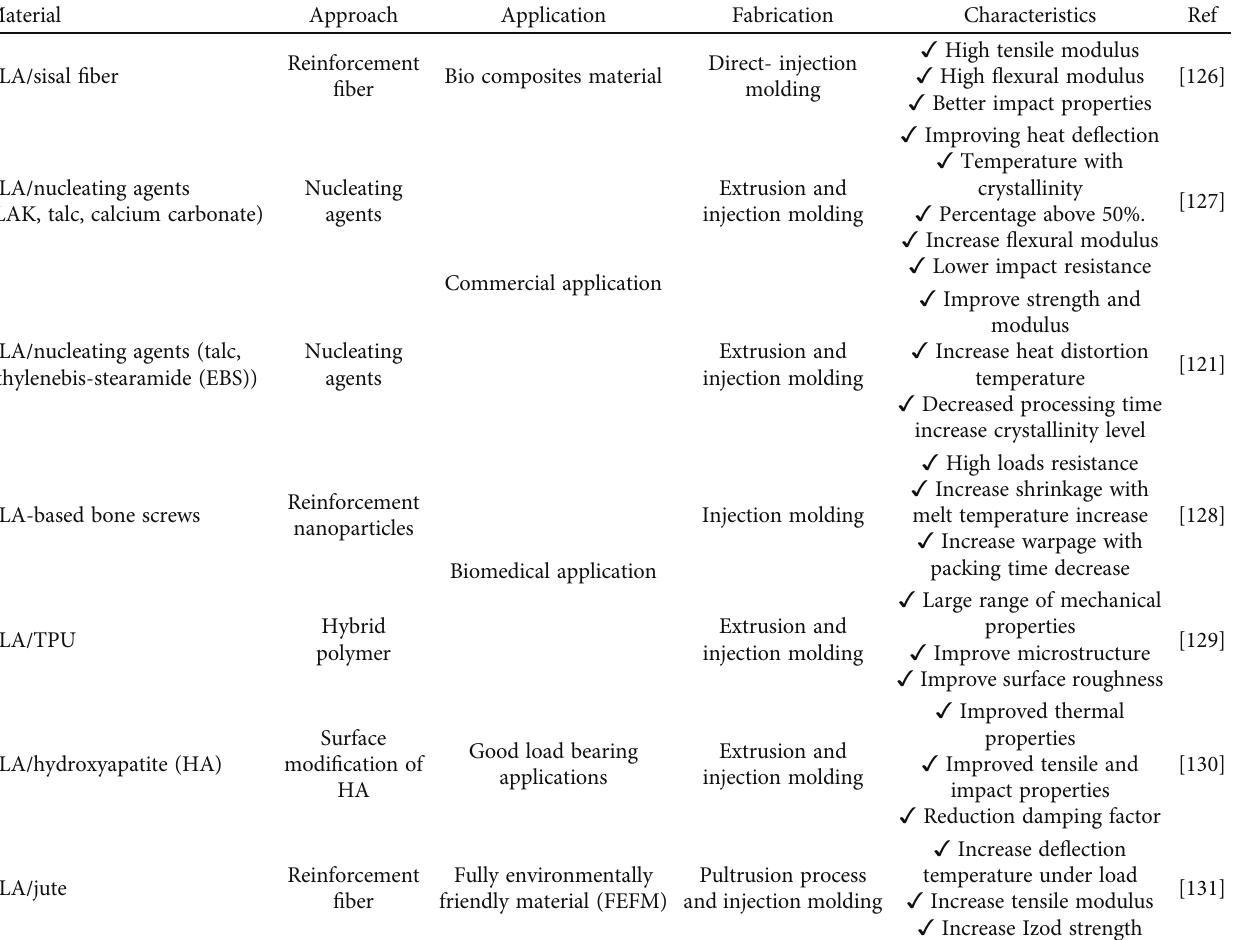
Table 11: Characteristic of PLA based material by using injection